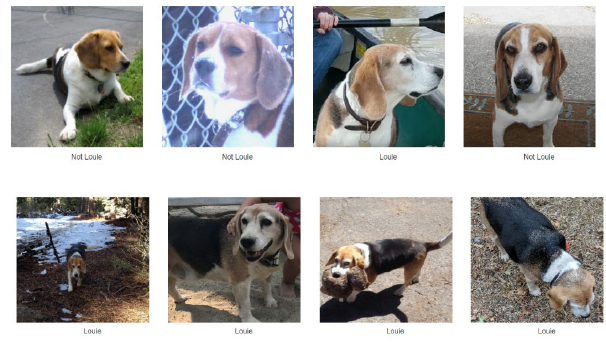
Figure 3. Dataset of